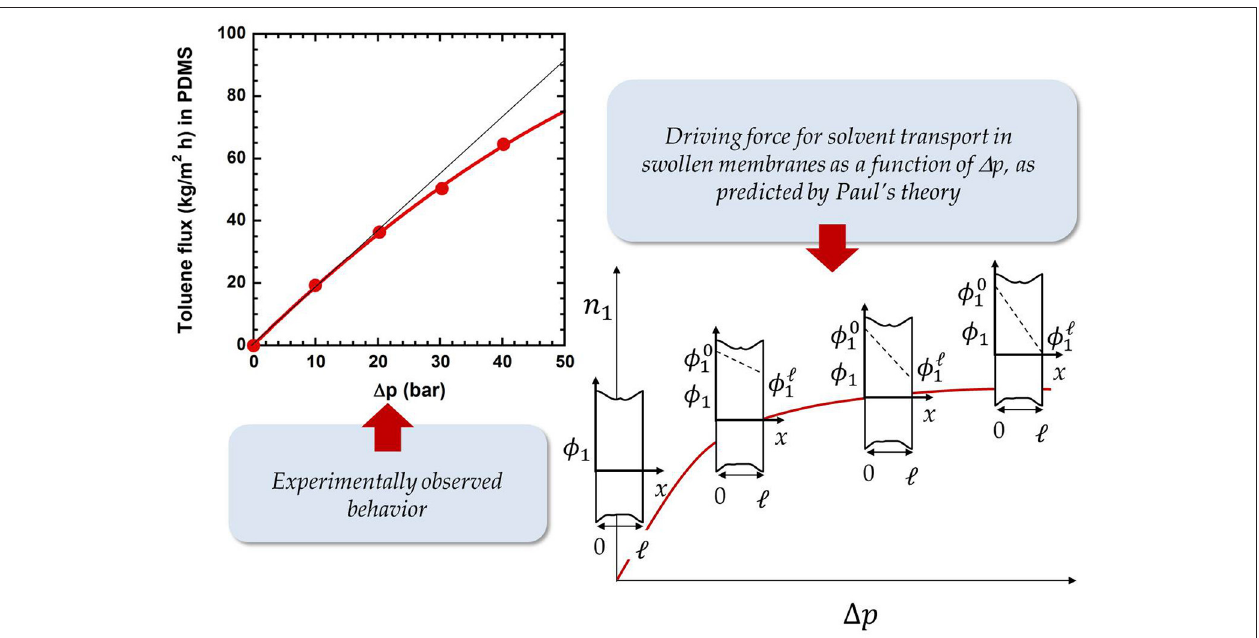
FIGURE 5 | Toluene flux through PDMS as a function of 1 p at room temperature. Data were taken from Postel et al. (2013). The evolution of driving force for solvent transport as a function of 1 p is reported as well, adapted from Paul (2004), with permission of Elsevier